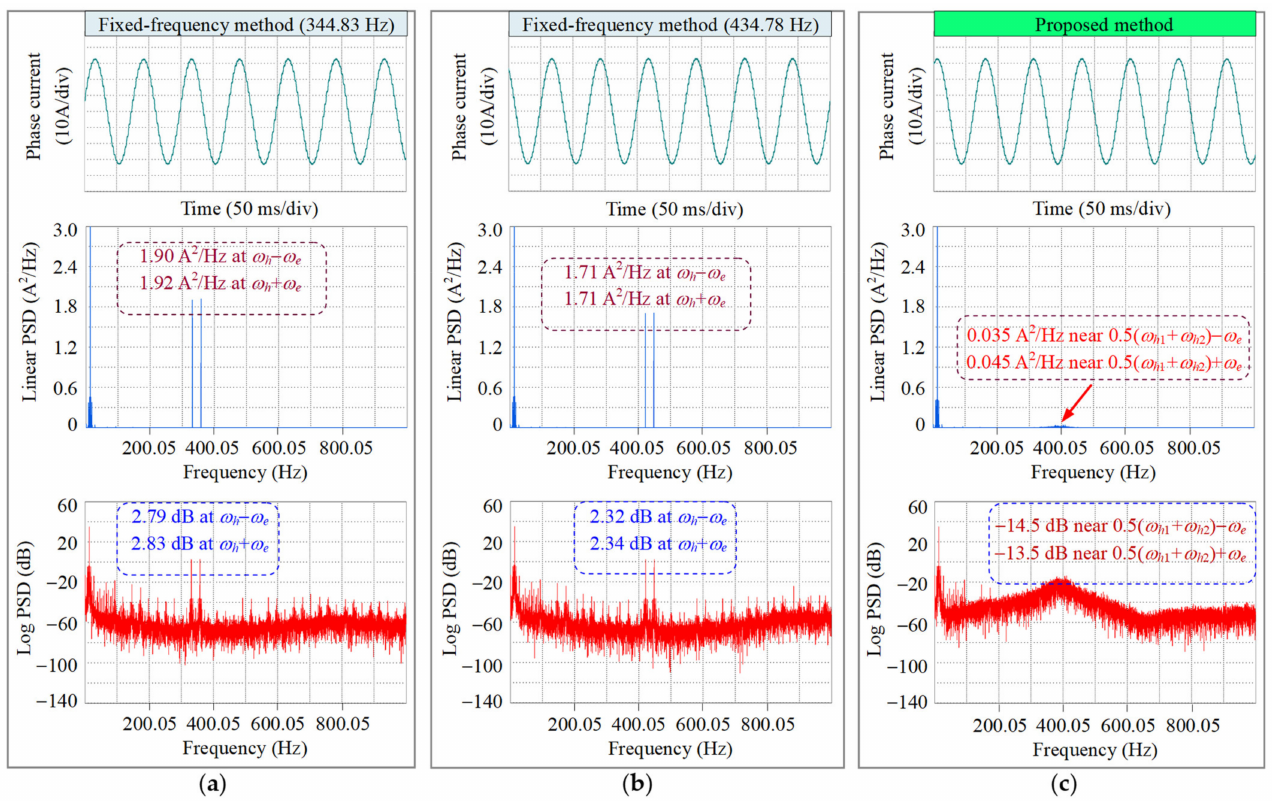
Figure 13. Stator phase currents and their PSD results of two different methods at 200 r/min under 30 N · m: ( a ) fixed-frequency method (344.83 Hz); ( b ) fixed-frequency method (434.78 Hz); ( c ) proposed PRFS method.